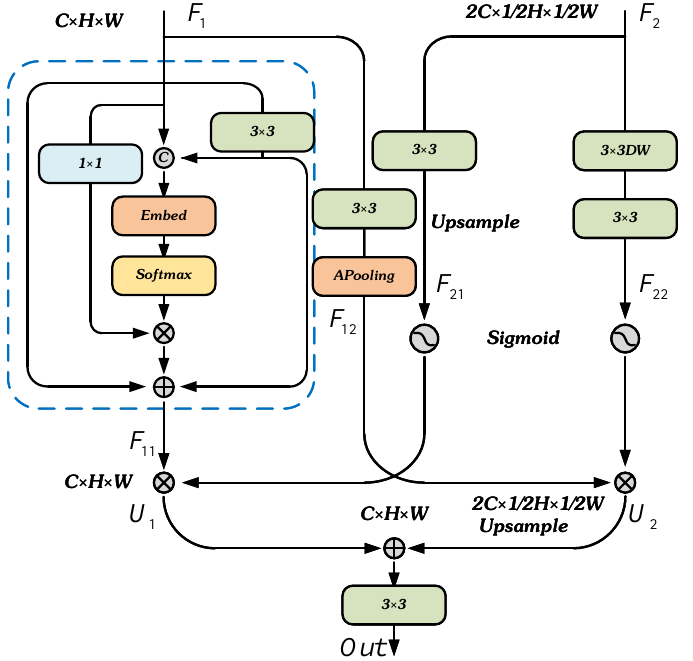
Figure 6. The structure of HFA. C, H and W represent the number of channels, height and width of the